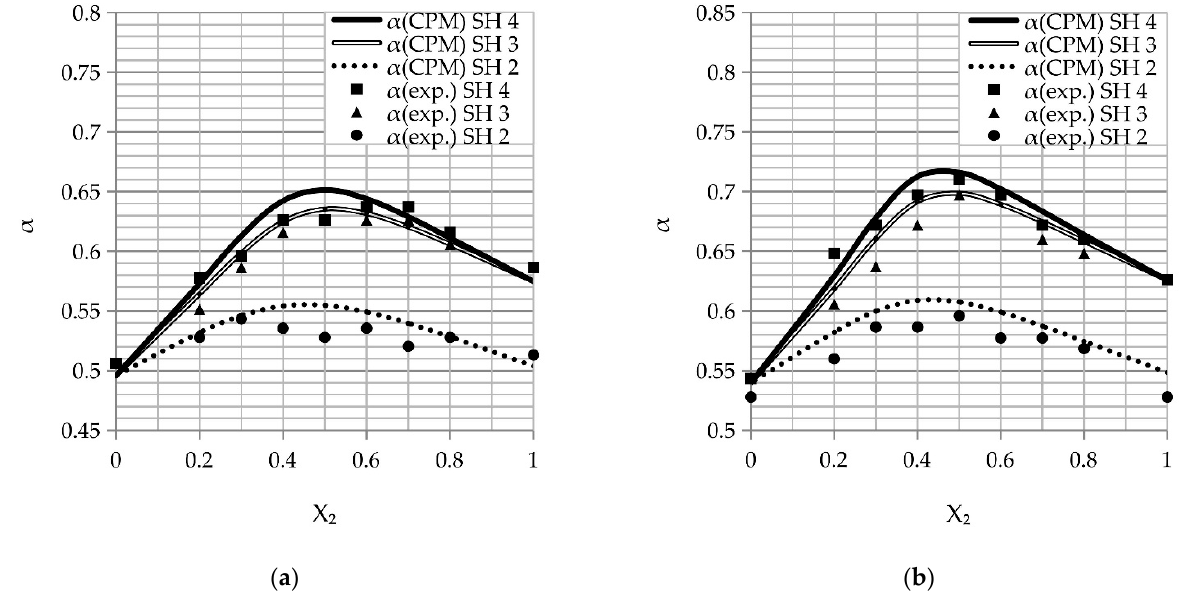
Figure 5. The plots of an experiment calculated by the De Larrard model showing the actual packing density of the double fracture ( α ) as a function of the second fracture (X 2 ) content in different packing processes: ( a ) pouring and ( b ) 10 impacts with a rod. Exp—experimental values, CPM—compaction packing model (De Larrard model).